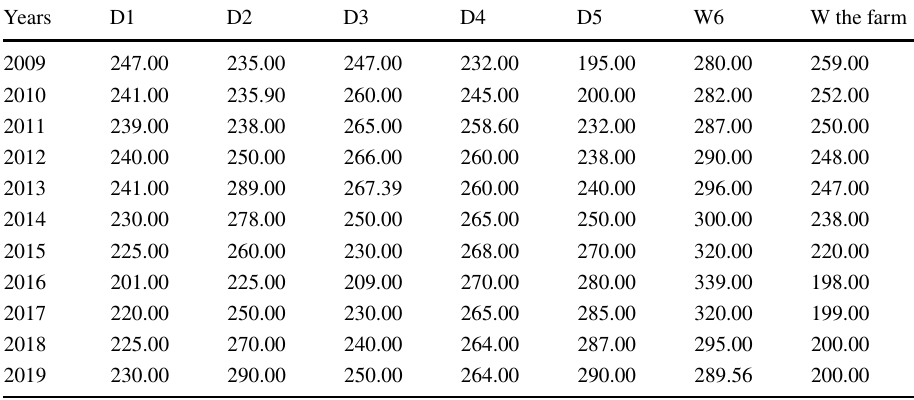
Table 11 Bicarbonate (mg/l) values of water points in the Mougheul area